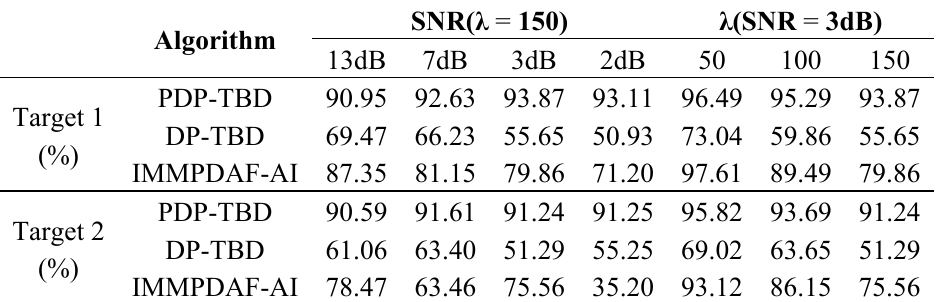
Table 2. Comparison of correct track probabilities (200 runs,